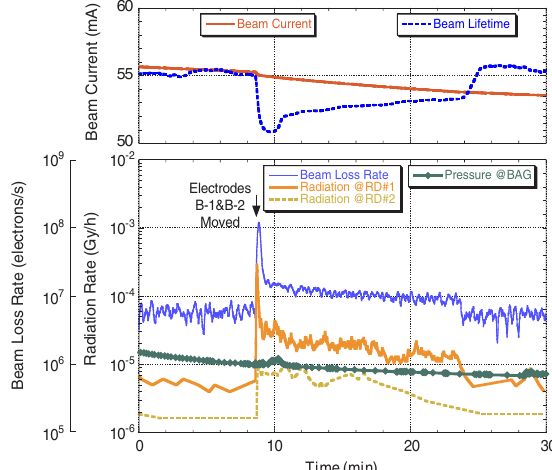
FIG. 9. (Color) Experimental data recorded when the beam life- time decreased because of electric discharge caused by beam- induced rf fields. The discharge was artificially induced by bringing electrode B-2 to the vicinity of the electron beam at the time indicated by the arrow. The decrease in the beam lifetime lasted for 98 min in this experiment (not shown in the